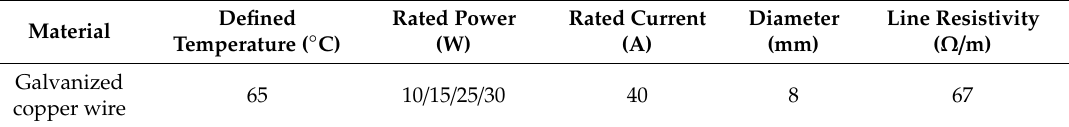
Figure 2. Heating cable and fiber diagram. Table 1. Parameters of used heating